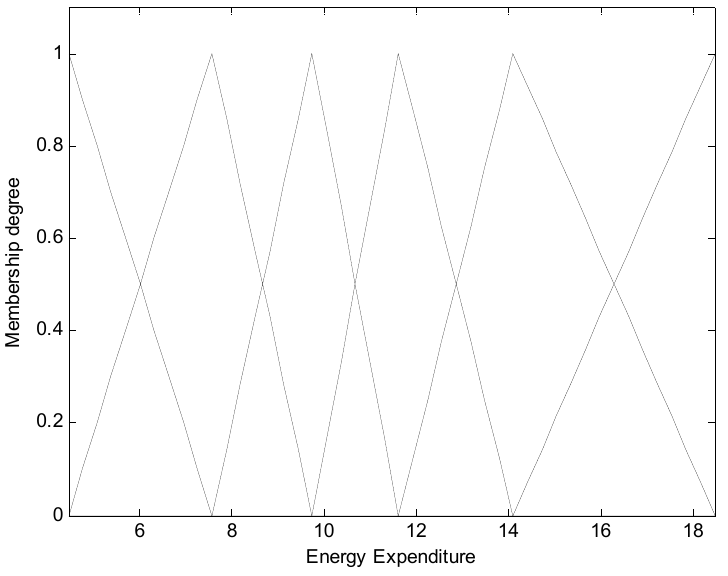
Figure 9. Linguistic contexts produced in output space (p = 6).